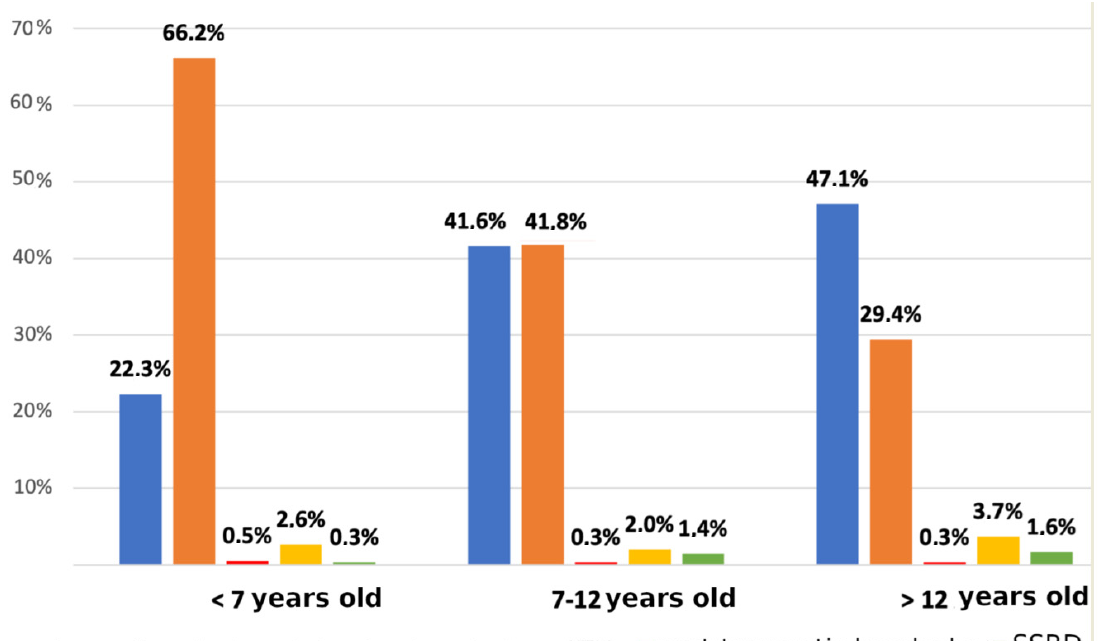
Figure 1. Age distribution of not life-threatening headaches. LTH: life-threatening headache; SSRD: somatic symptom and related disorder.